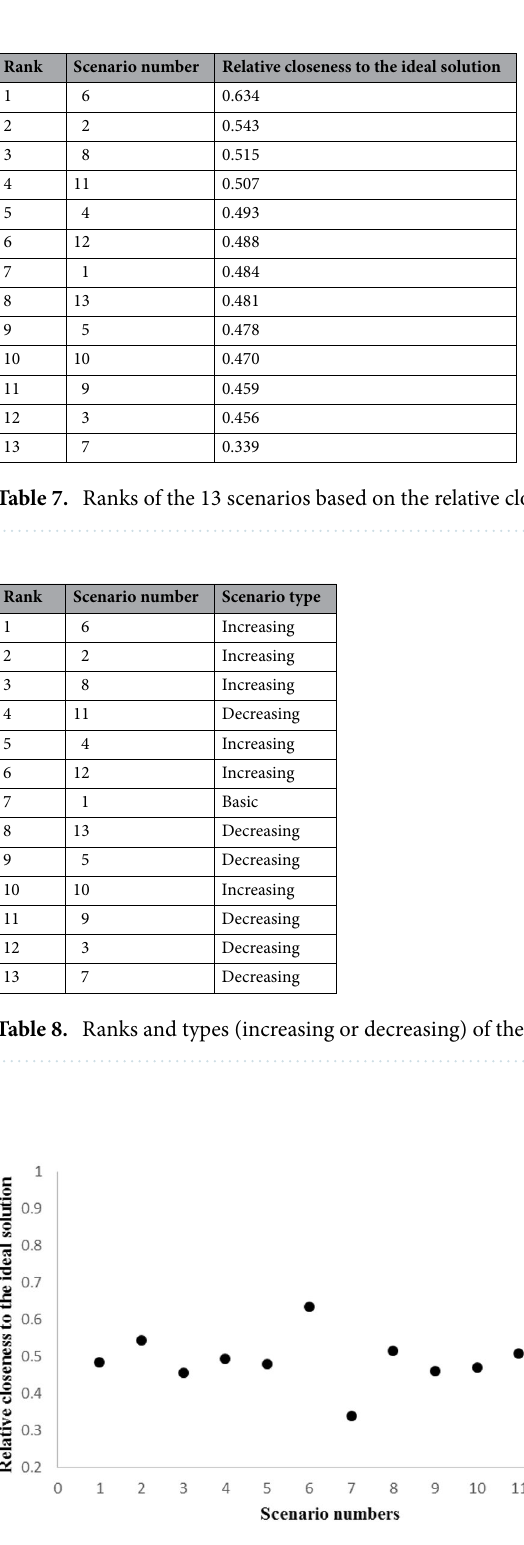
Figure 6. Relative closeness to the ideal solution for the 13 scenarios.